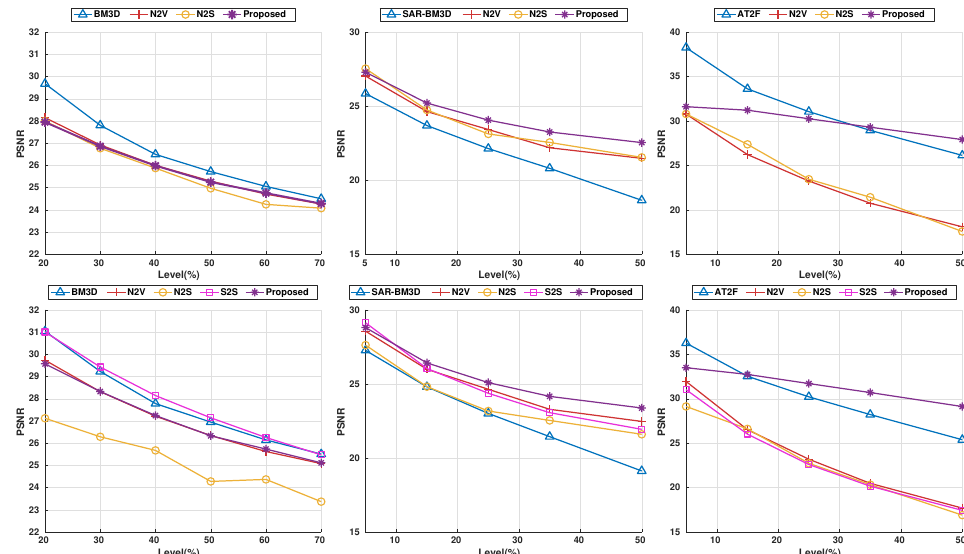
Figure 4. Quantitative performance comparison of various denoising methods on known noise models in the BSD68 and Set14 dataset. Left to right: AWGN, speckle noise, and salt-and-pepper, respectively. Top to bottom: BSD68 and